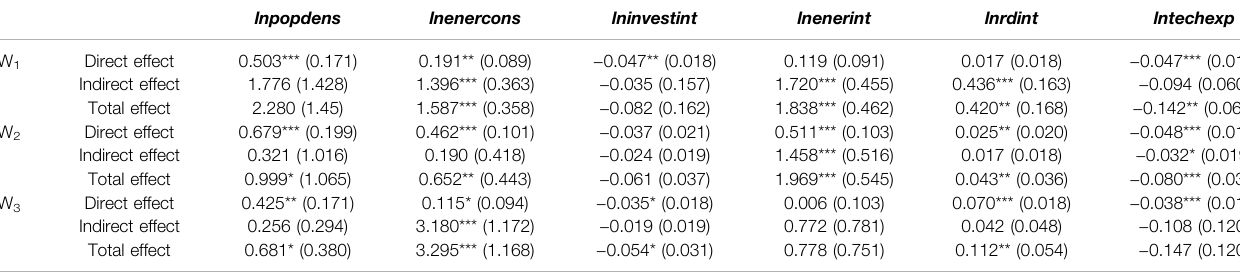
TABLE 7 | Estimation results of decomposition of the